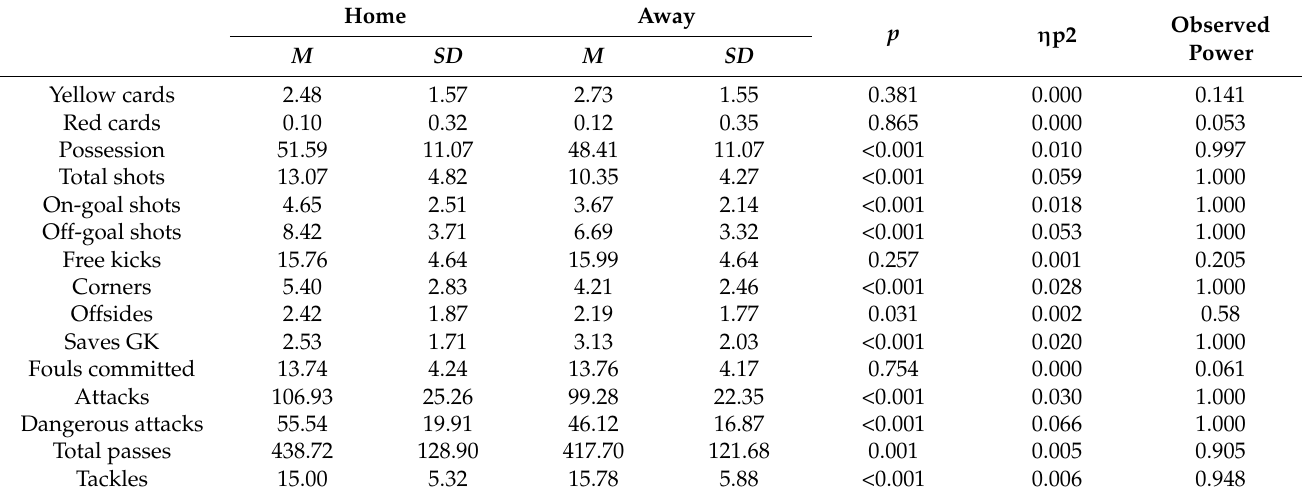
Table 3. Descriptive and inferential results of venue.